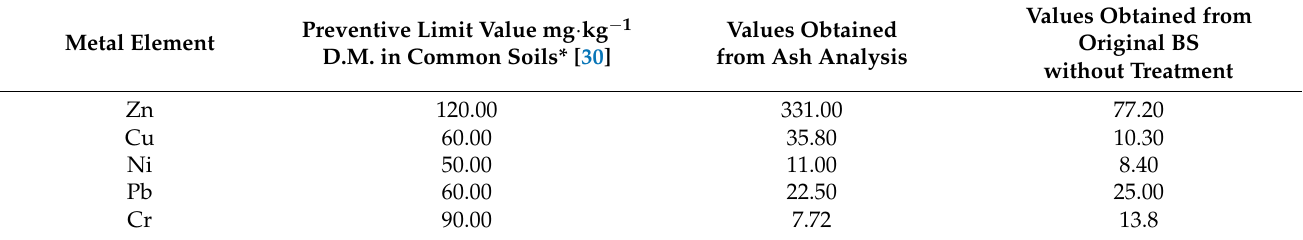
Table A3. Metal element concentrations in the Decree on Protection of Agricultural Lands with